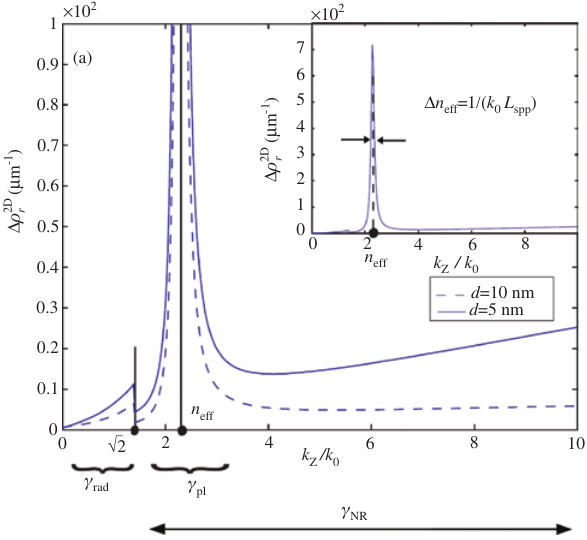
Figure 2: Plot of the modified two-dimensional density of states, 2D , ρ ∆ as a function of normalized longitudinal wavenumber k u where k is the wavenumber of the surrounding, for a dipole located 0 a distance d from a cylindrically shaped silver nanowire with a radius of 20 nm [36]. The dipole is radially oriented with respect to the wire surface and located in a homogeneous material with ε = 2. The contributions of Δ ρ to γ , γ , and the nonradiative mode γ rad pl indicated at the bottom of the figure. The large contribution of the guided plasmon mode is highlighted by the peak centered around = 2.28 of the plasmon the effective mode index n eff